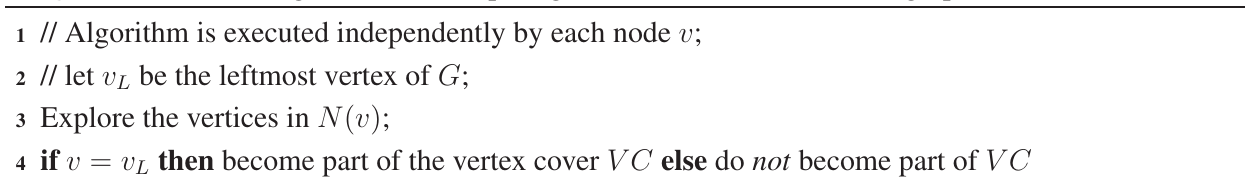
Algorithm 8 : Local algorithm for computing a vertex cover in a unit line